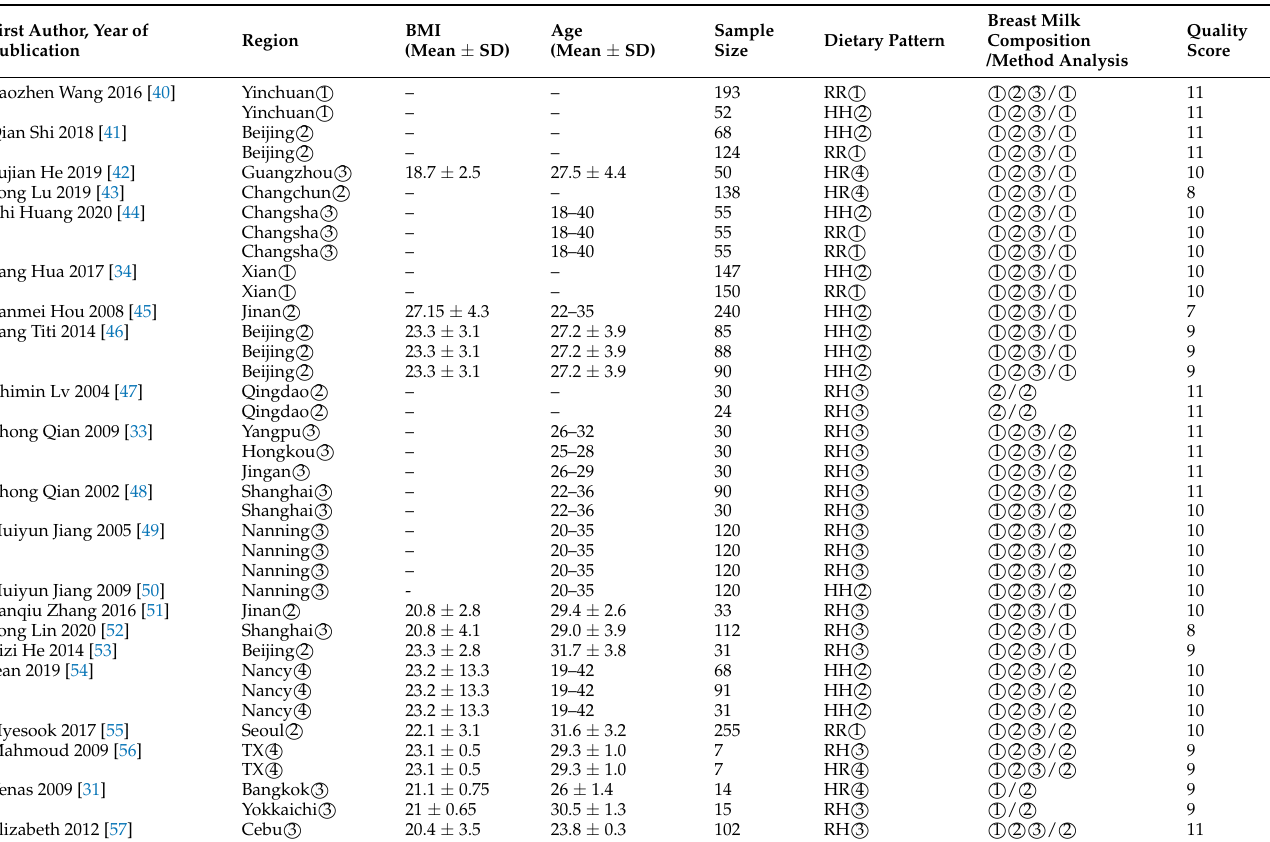
Table 1. Characteristics of the included studies in different sample